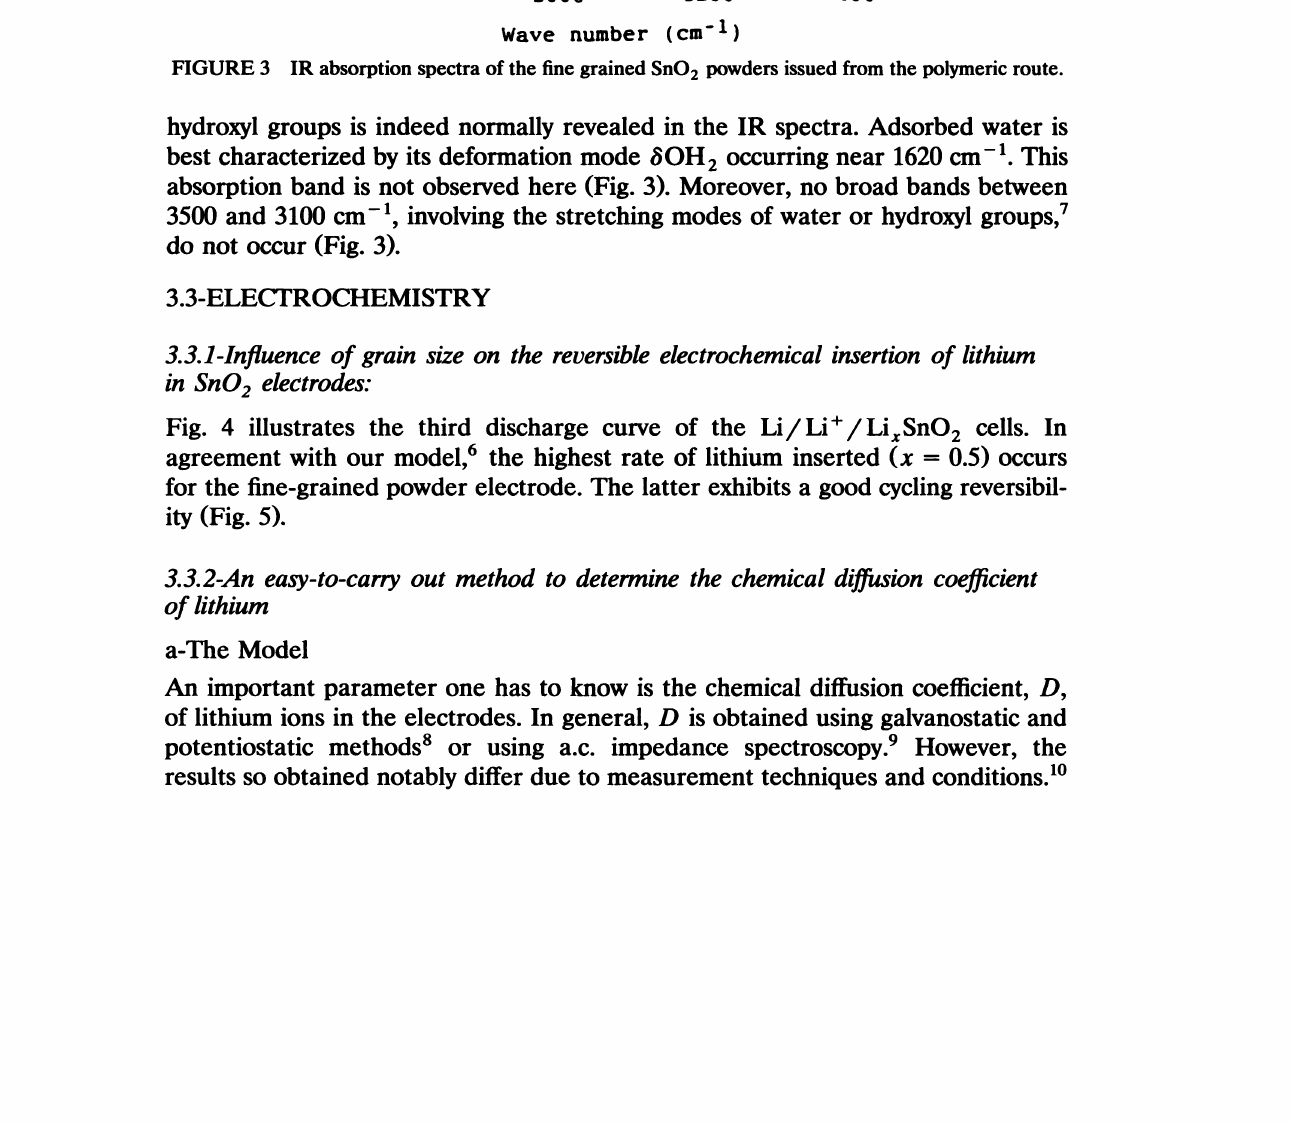
FIGURE 3 IR absorption spectra of the fine grained SnO